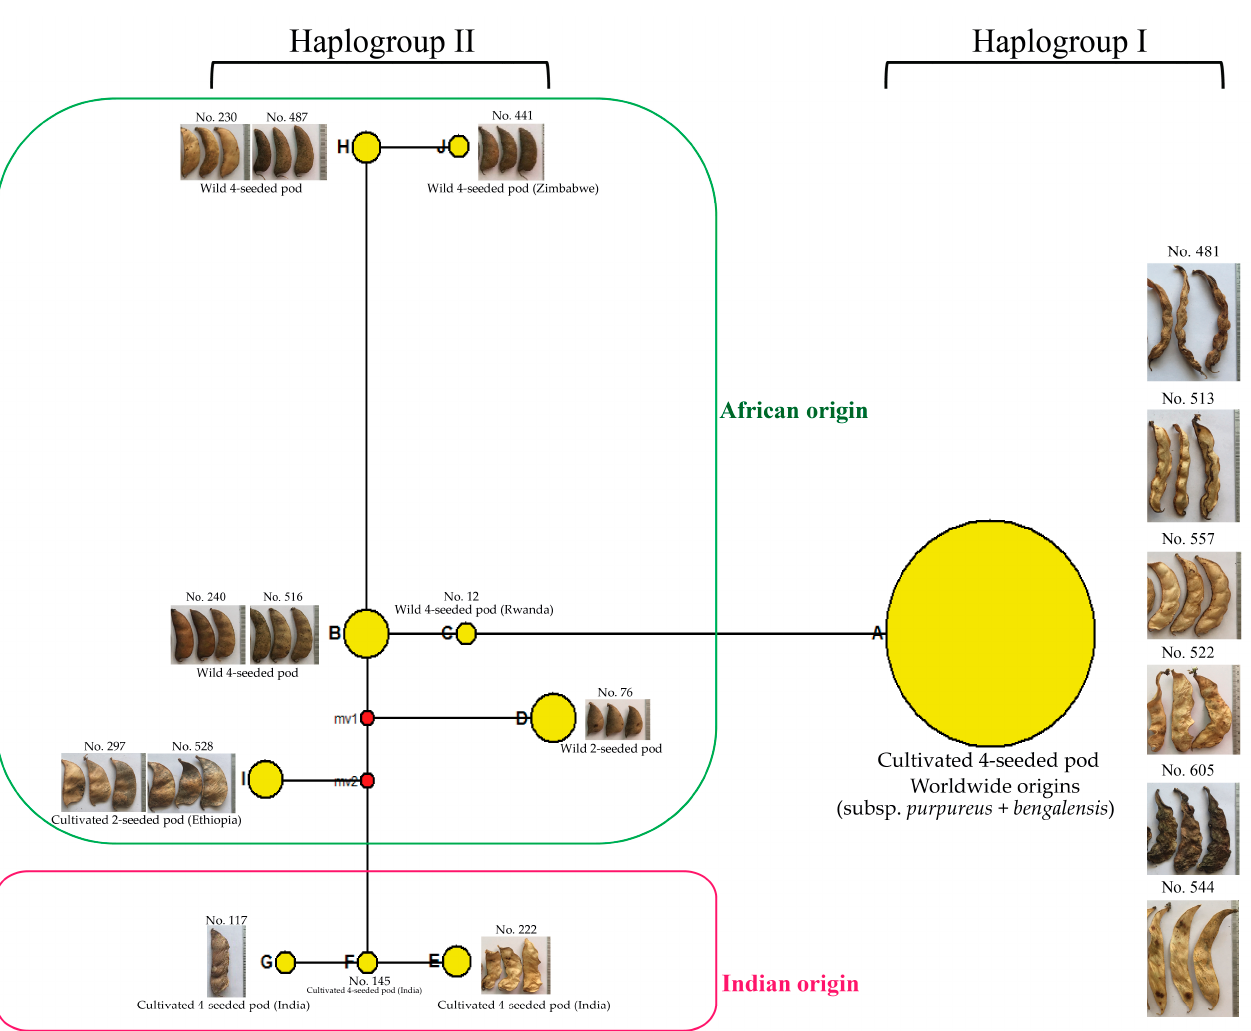
Table 6. Number of alleles per locus, observed heterozygosity, allelic richness, and gene diversity of core collection (47 accessions) of lablab.